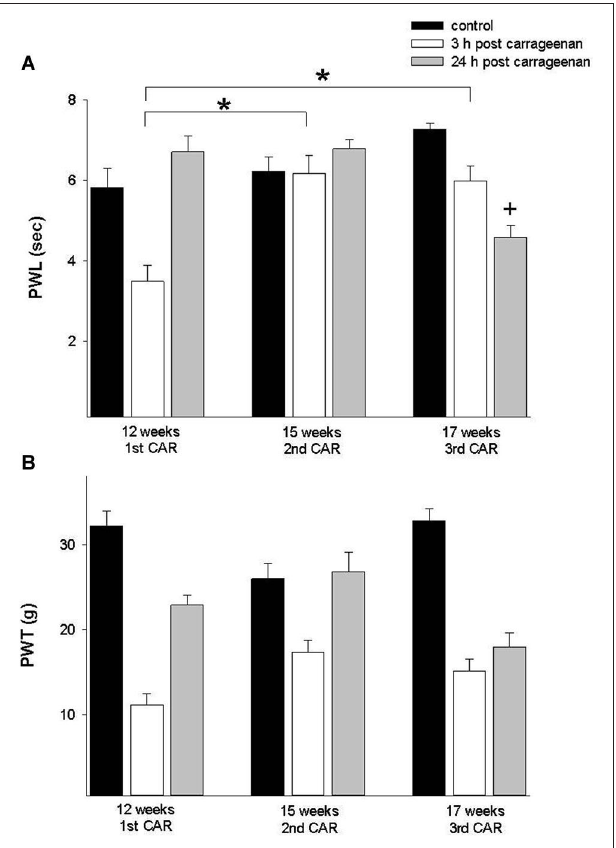
FIGURE 4 | (A) Effect of a first time CAR infiltration at 12 weeks old, and repeated CAR application at 15 and 17 weeks of age. Notice a significant increase in PWL 3 h after injection (white bars) in comparison with mean values obtained at 12 weeks ( * p = 0.01). (B) Similar changes are observed in PWT at 12 and 15 weeks. Data are expressed as mean ±